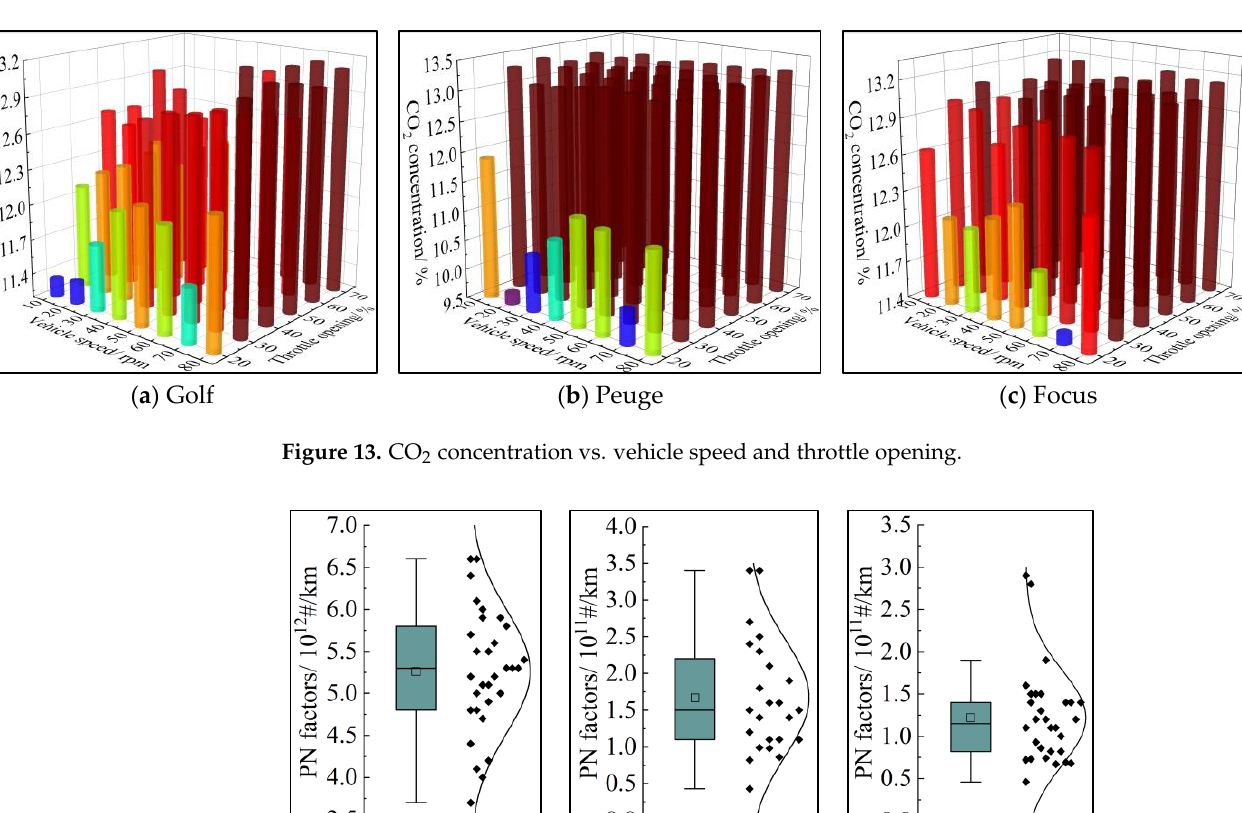
Figure 13. CO 2 concentration vs. vehicle speed and throttle opening.